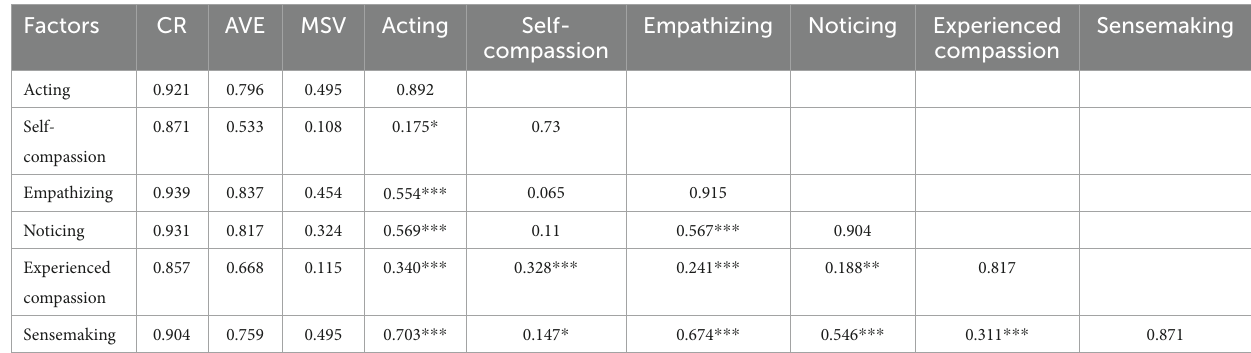
TABLE 9 Convergent and discriminant validity analysis for differentiating other related constructs ( N = 255).